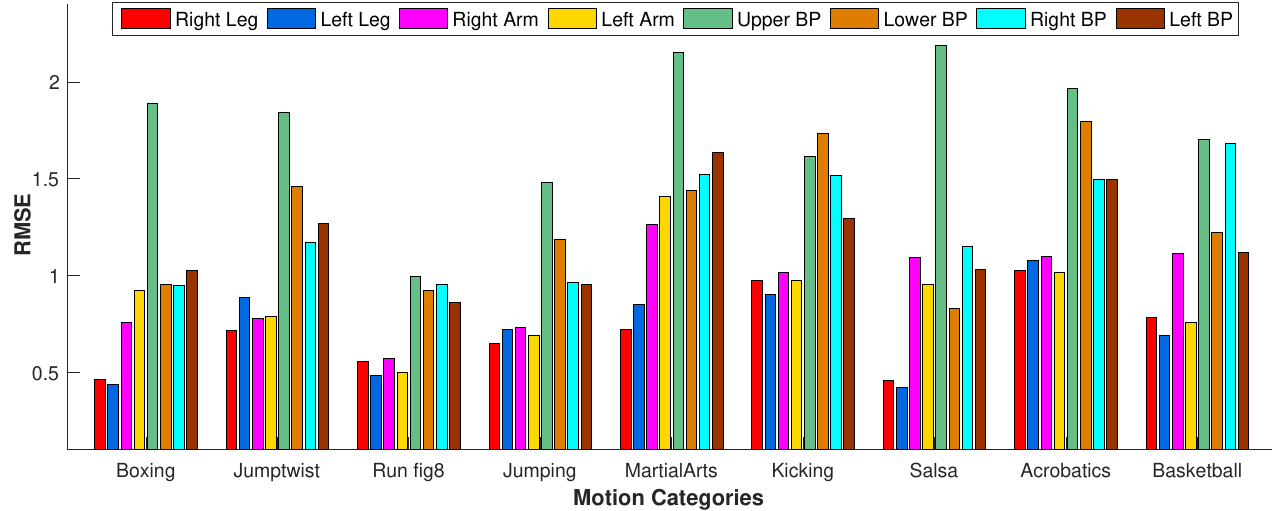
Figure 15. The impact of the missing joints of the different body parts regarding